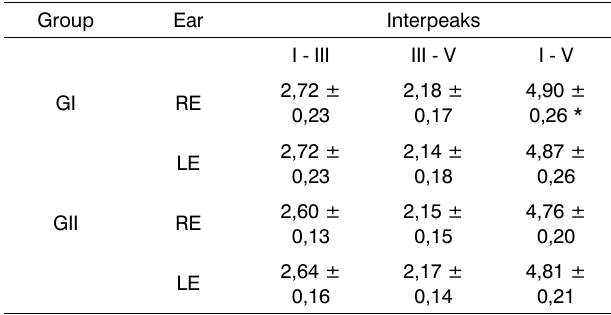
Table 2. Mean and standard deviation of interpeak latencies LI - III, LIII - V and LI - V in each study group (in